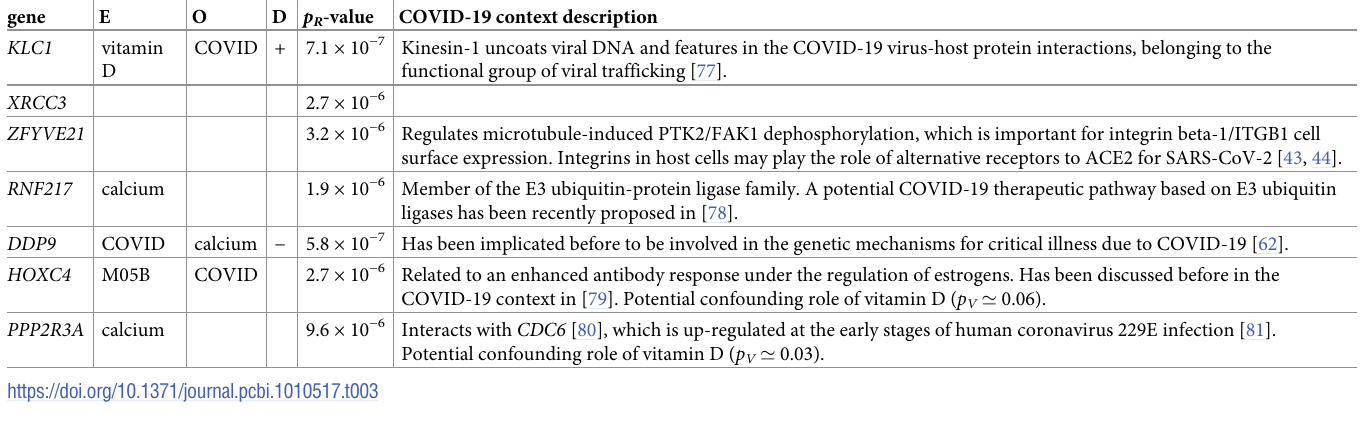
Table 3. Table of genes of significance ( p < 10 − 6 ) detected via ratio tests against COVID-19. The column E lists the exposure, O the outcome, and D the test direction, with + for coherent and − for anti-coherent. We confirmed that all listed genes are p V significant under the exposure, but not the outcome. gene E O